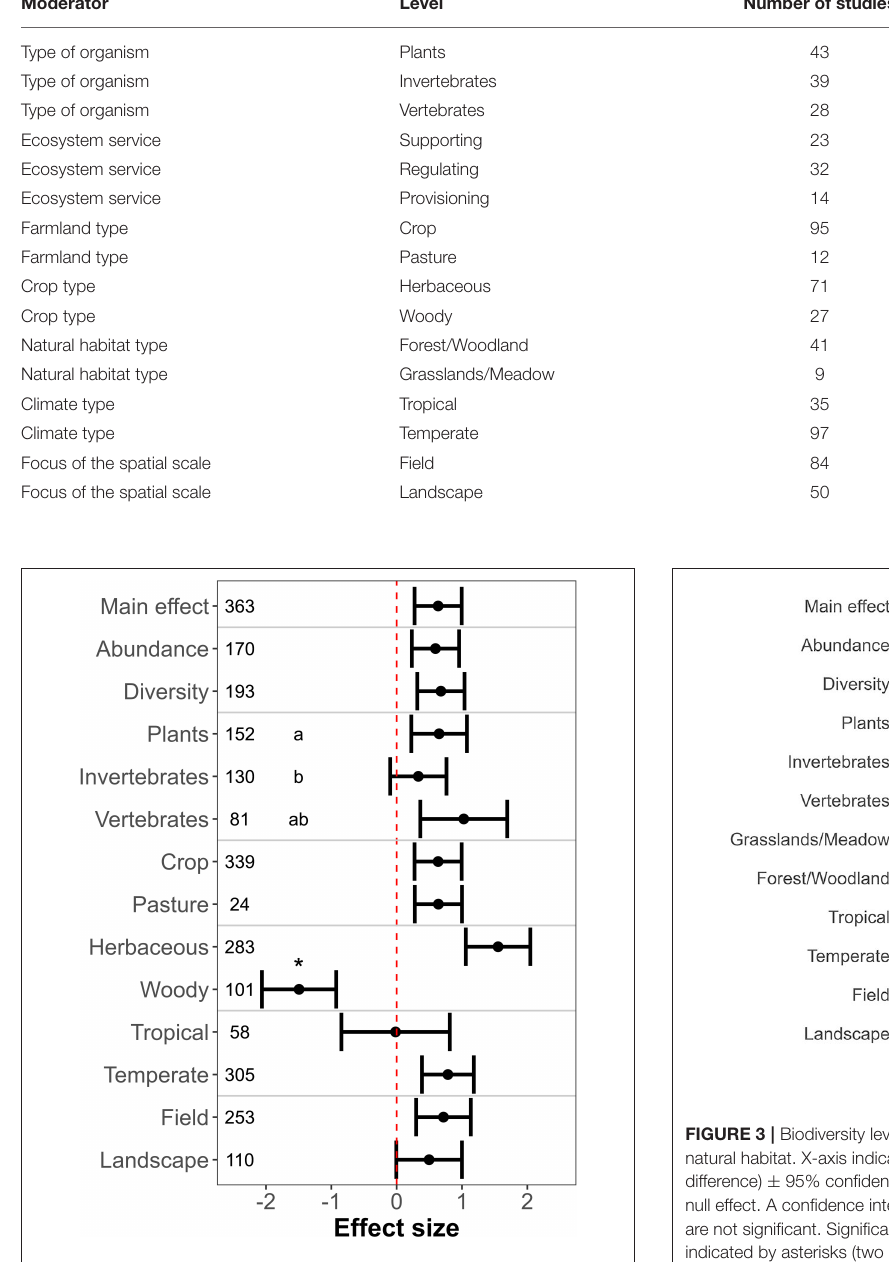
FIGURE 2 | Biodiversity levels in farmland with hedgerows as compared to farmland without hedgerows. X-axis indicates the mean effect size (standardized mean difference) ± 95% confidence interval. The dashed vertical red line shows the null effect. A confidence interval that overlaps this line means that the effects are not significant. Significant differences between levels of moderators are indicated by asterisks (two levels) and different letters (three levels), respectively.